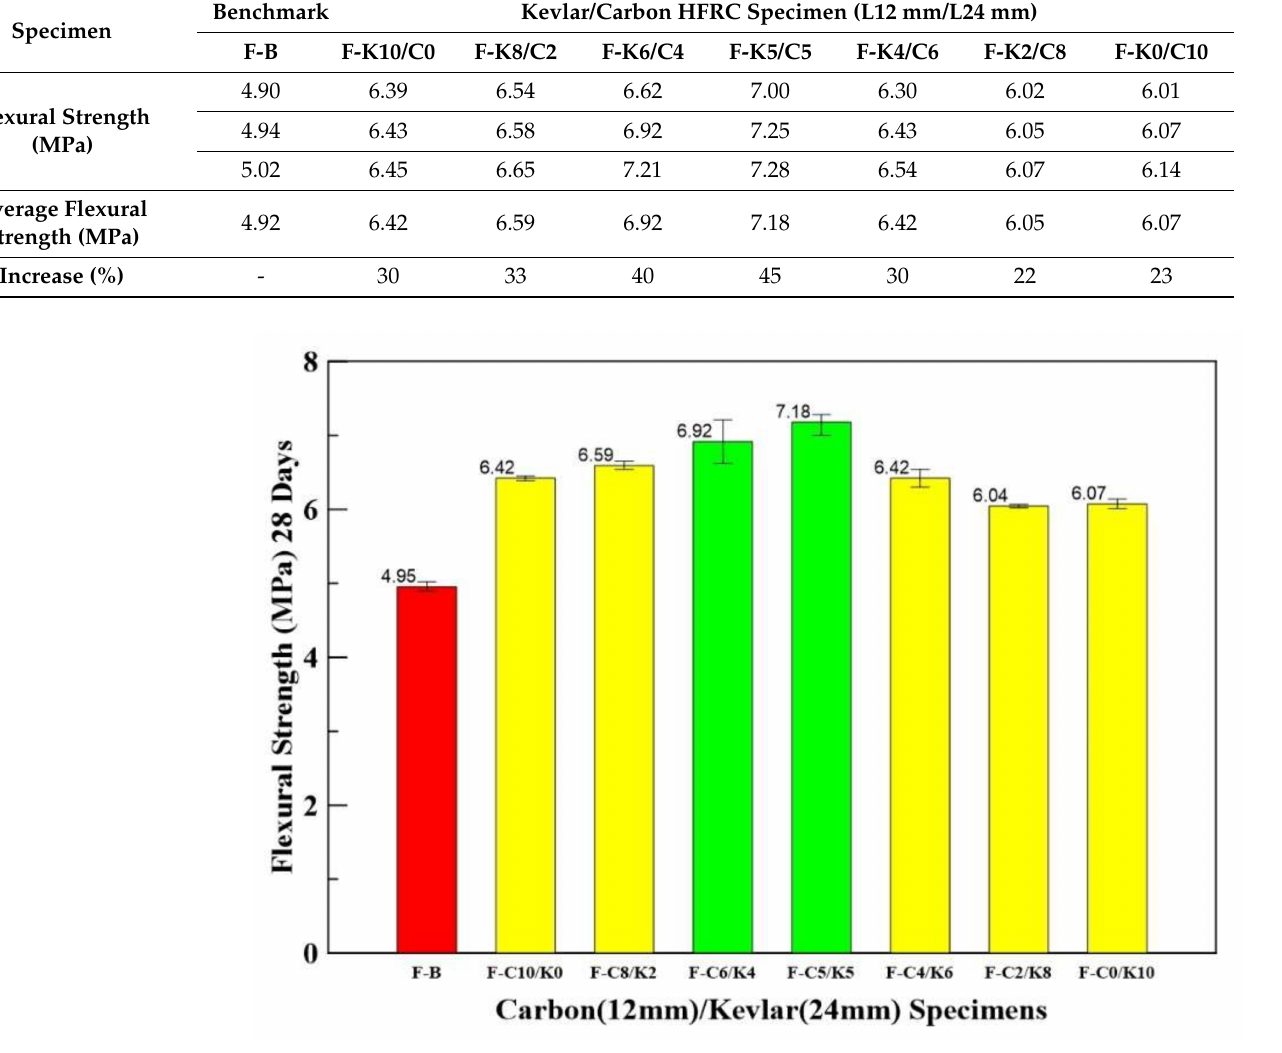
Figure 9. Bar chart for average flexural strengths of benchmark and carbon/Kevlar HFRC